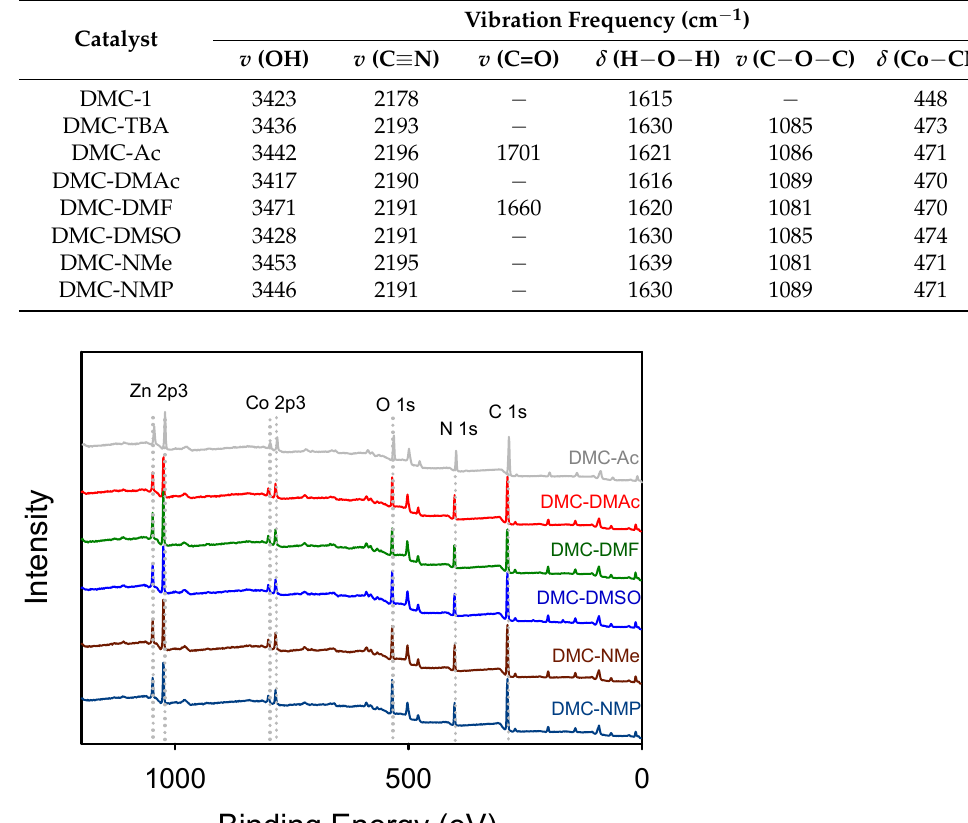
Table 1. Summary of the FTIR results of DMC catalysts prepared by different CAs.